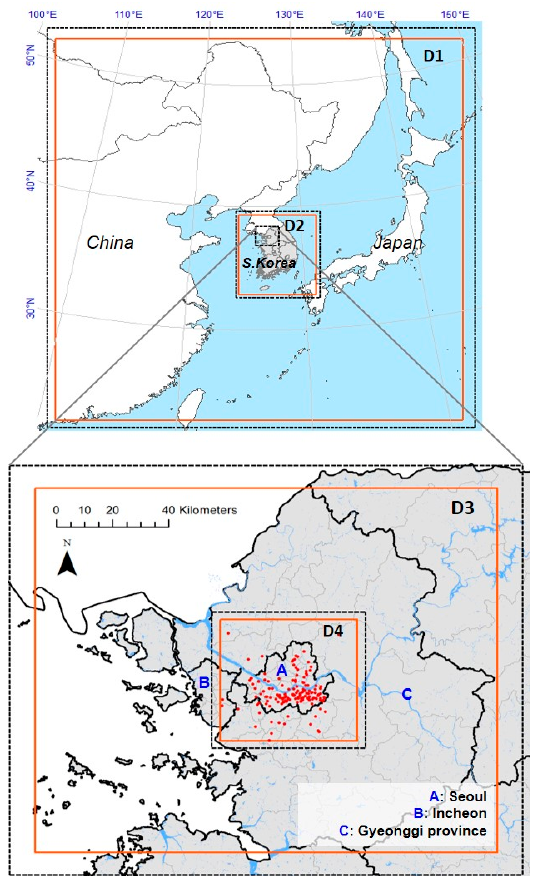
Figure 1. A map of the study area (D4), the residences of the atopic dermatitis patients (red dots), and modeling domains (D1–D4). Black dashed lines indicate the domains for the weather research and forecasting (WRF) model. The solid red line reflects the community multiscale air quality (CMAQ) modeling. The study area (D4) includes Seoul (A) and parts of Incheon (B) and Gyeonggi provinces (C).